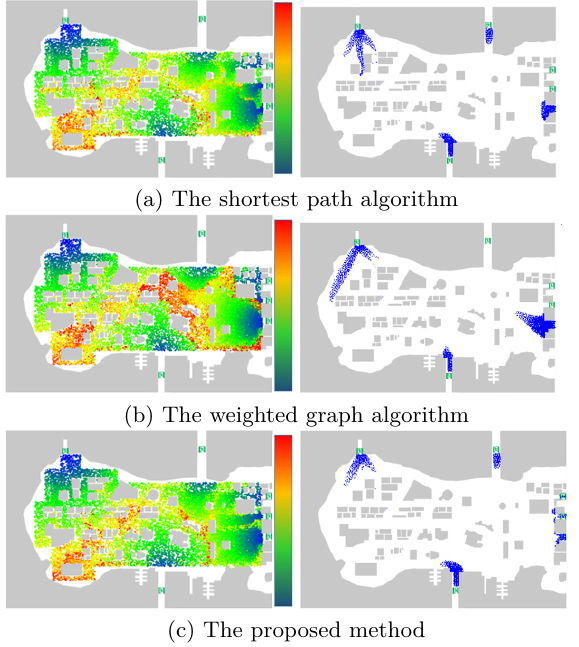
Fig. 11 Island example. Left: distribution of the agent travel time. Right: remaining agents at frame 4500. Agents are moving to all six exits in our method, but some exits are no longer utilized in the other two